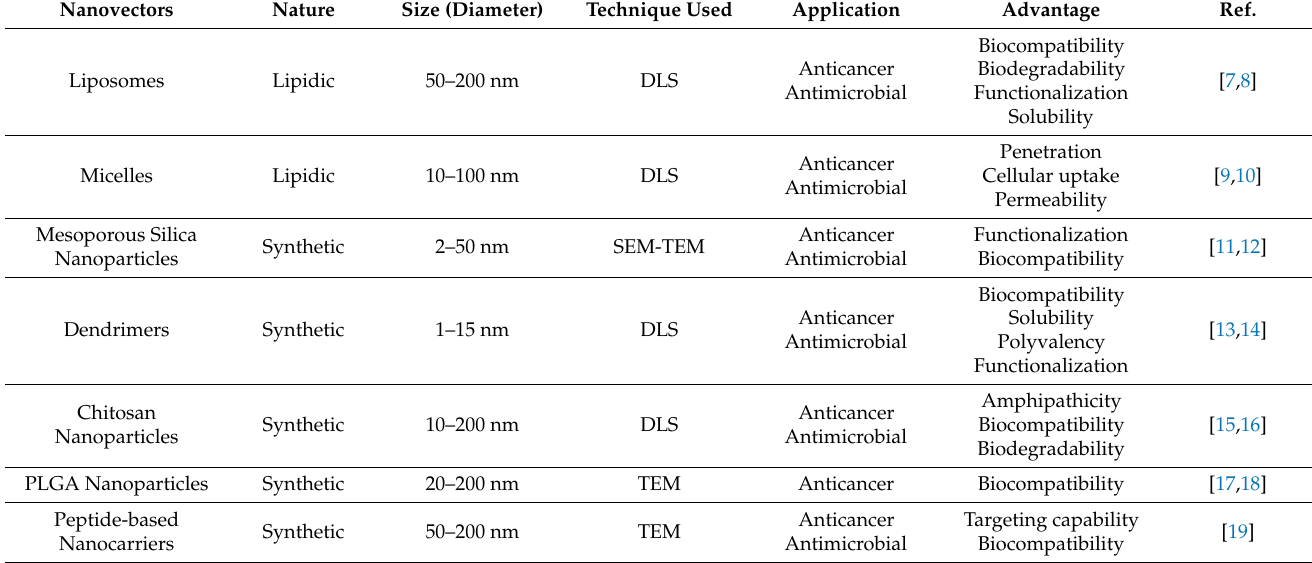
Table 1. Classification of the most common nanovectors, their structures and